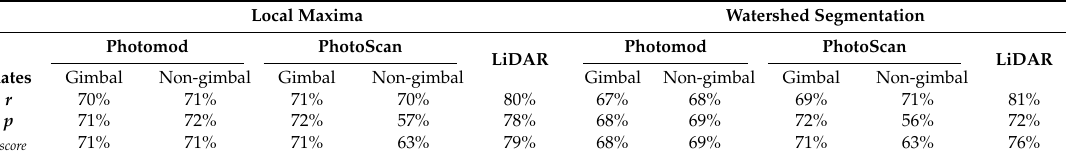
Table 5. Eucalyptus spp. tree (height > 10 m; n = 258) detection rates (r) , using Equations (2)–(4), correctness of the detected trees ( p ), and overall accuracy (F score ) based on local maxima and watershed segmentation results using raster 40-cm